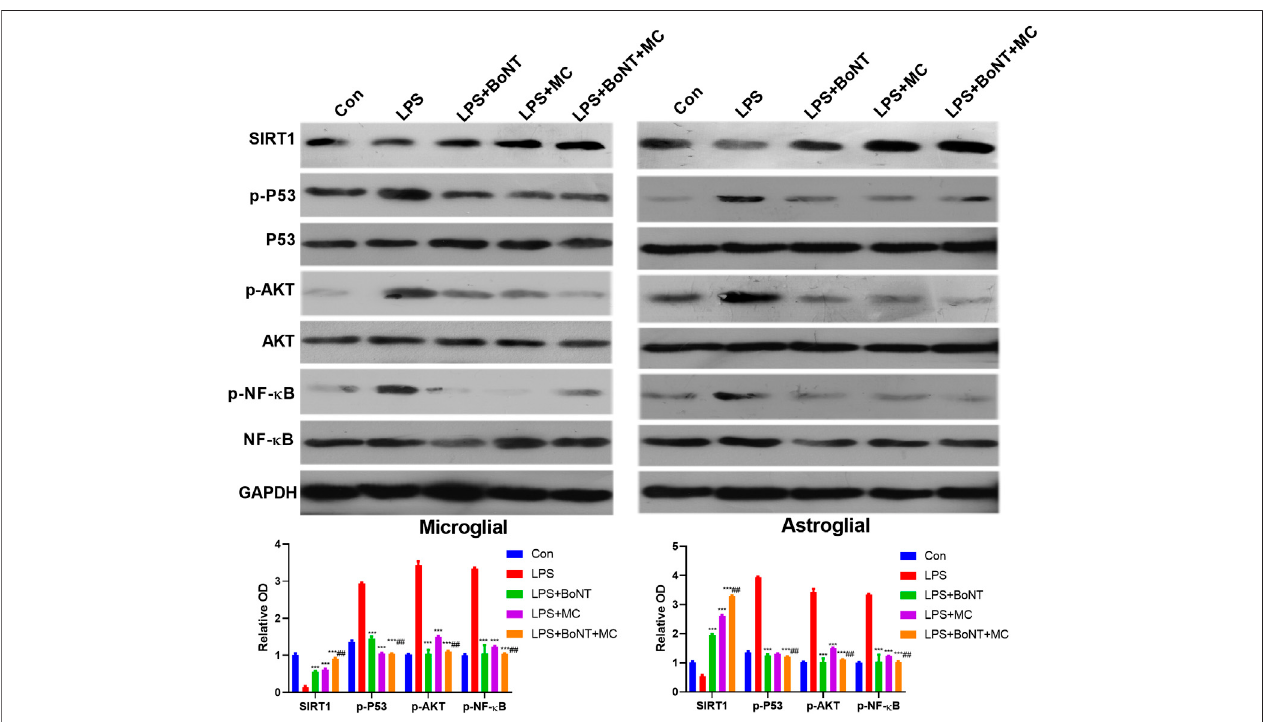
FIGURE 6 | Combination of BoNT and MC dramatically activated SIRT1, inhibited AKT of glial cells. Western blot was used to detect changes in related signaling moleculesofSIRT1,AKT,P53,NF- κ Banditsphosphorylation(* p < 0.05,** p < 0.01,*** p < 0.0001 V.SLPS; # p < 0.05, ## p < 0.01, ### p < 0.0001 V.SLPS+BoNTorand LPS + MC, N (cid:2)